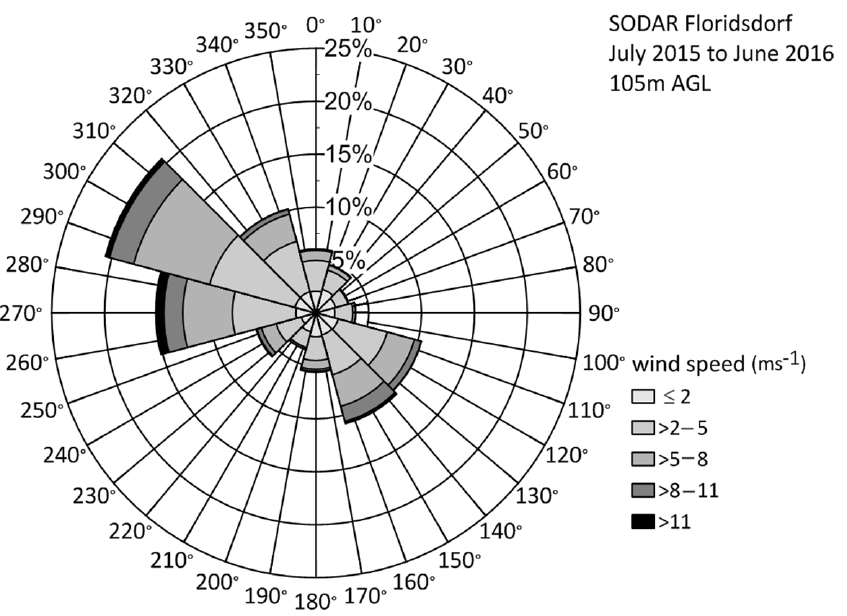
Figure 3. Frequency distribution of wind speed and wind direction depicted as wind rose from one year of SODAR data measured at 105 m AGL (10 min averages observed from 01.07.2015 00 MEZ to 30.06.2016 23:50 MEZ).